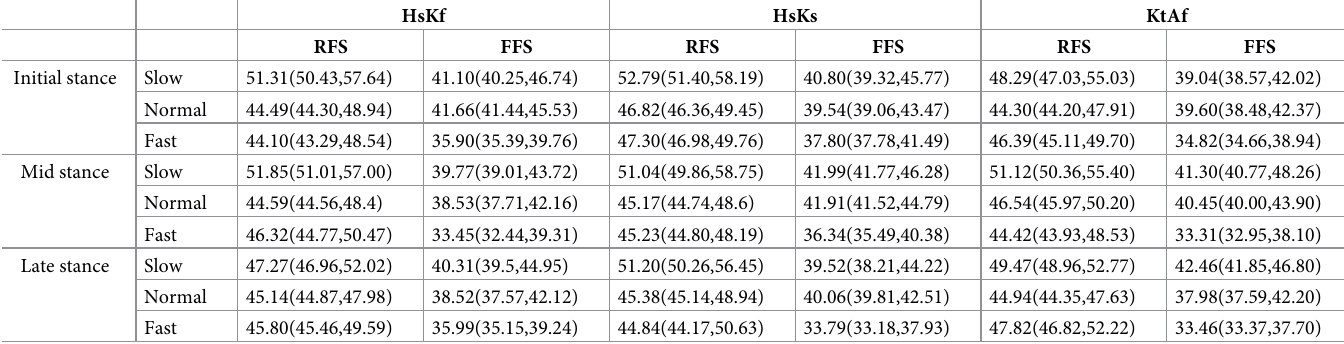
Table 2. M (P25 and P75) for coordination variability of selected couples at six running conditions during three stance